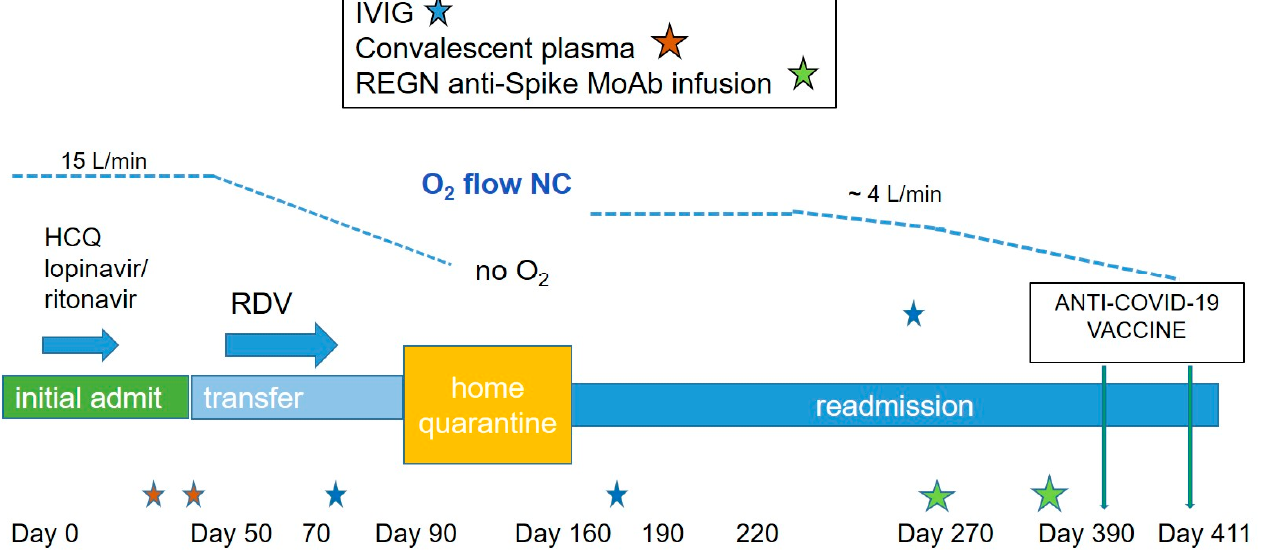
Figure 3. Clinical course, therapies, virus detection. Chronological presentation of patient’s course, including supplemental oxygen required, therapeutic interventions, anti-SARS-CoV-2 antibody results, and SARS-CoV-2 PCR results. NC = nasal cannula. HCQ = hydroxychloroquine. RDV = remdesivir. L/min = liters per minute. IVIG = intravenous immune globulin.